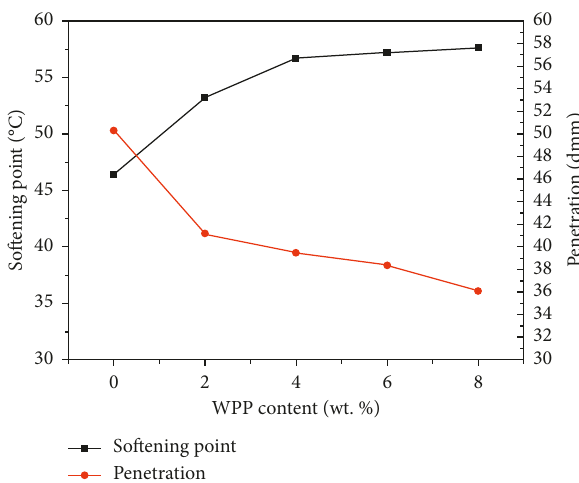
Figure 1: The softening point and penetration of WPP-modified